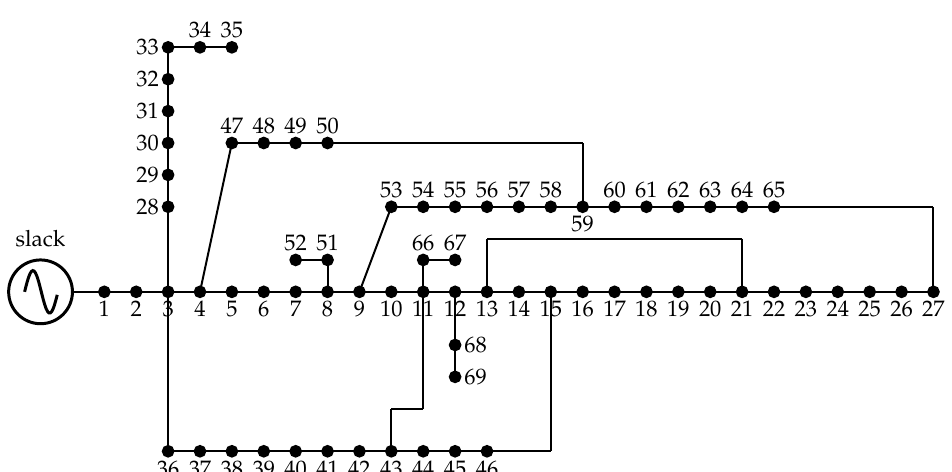
Figure 6. Schematic interconnection of the 69-node meshed test system.